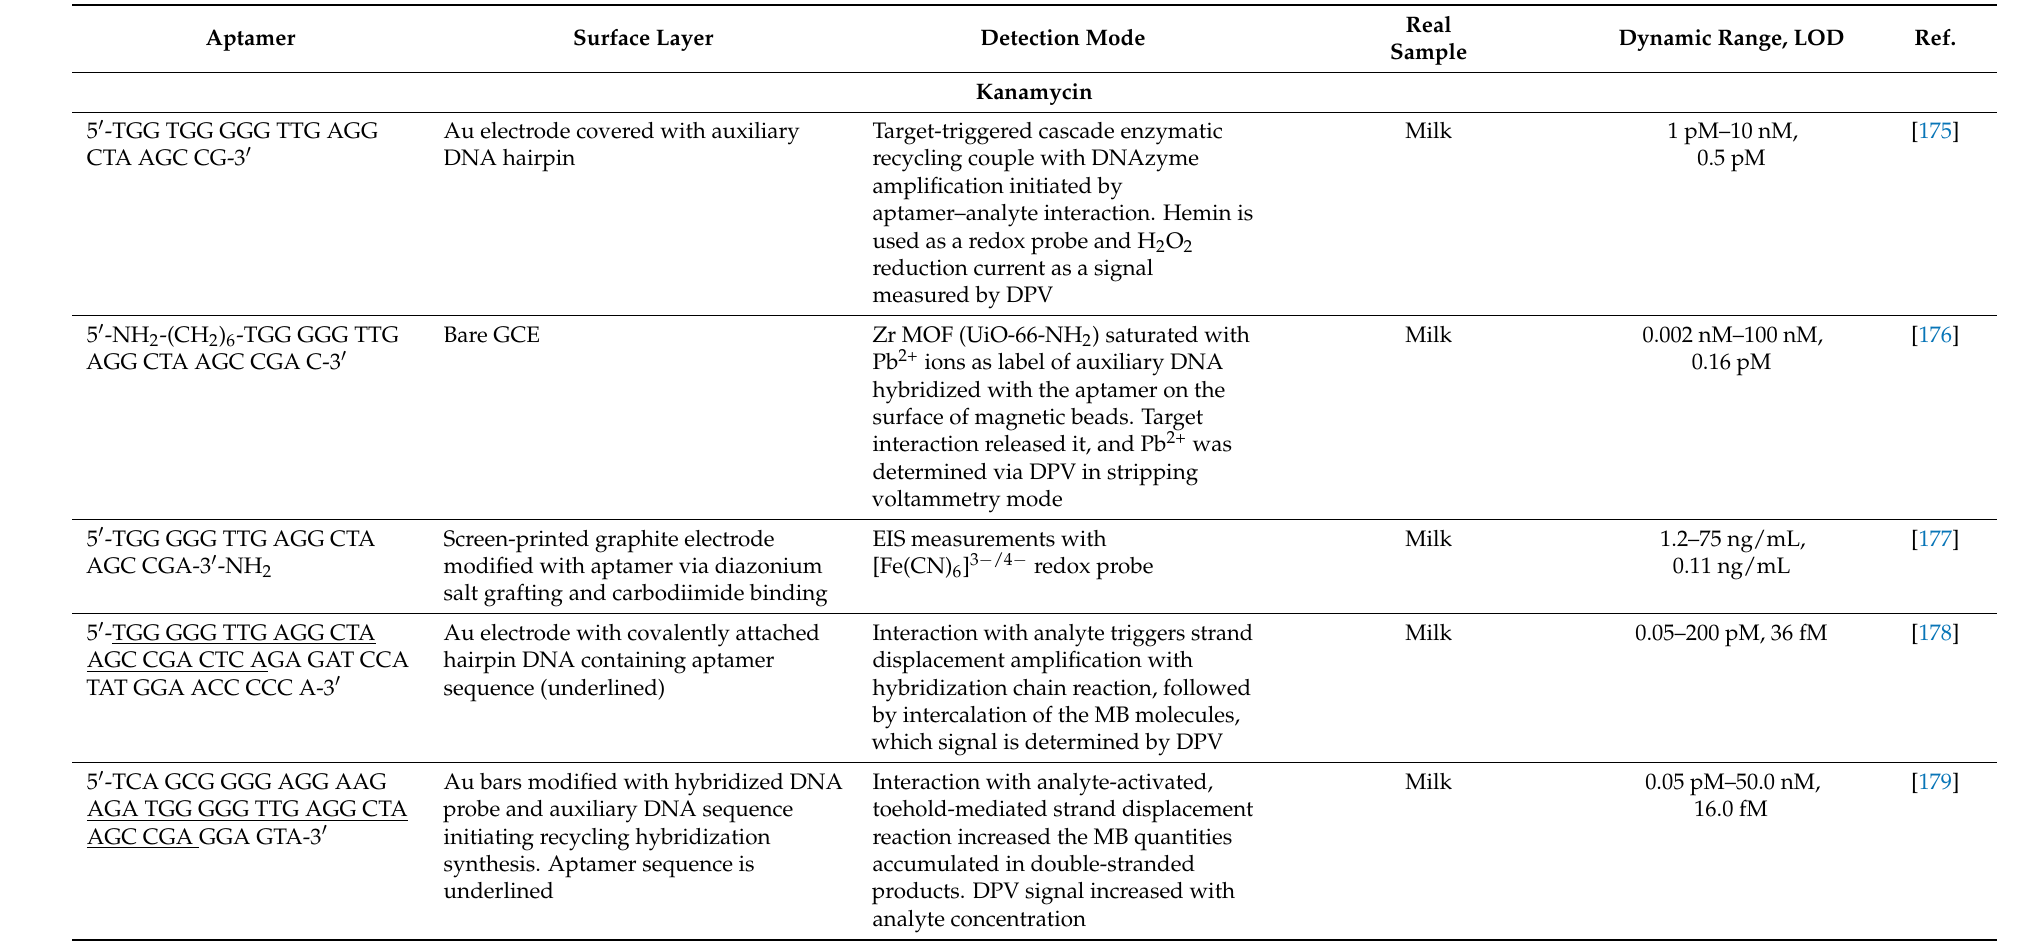
Table 2. Electrochemical aptasensors for antibiotic determination